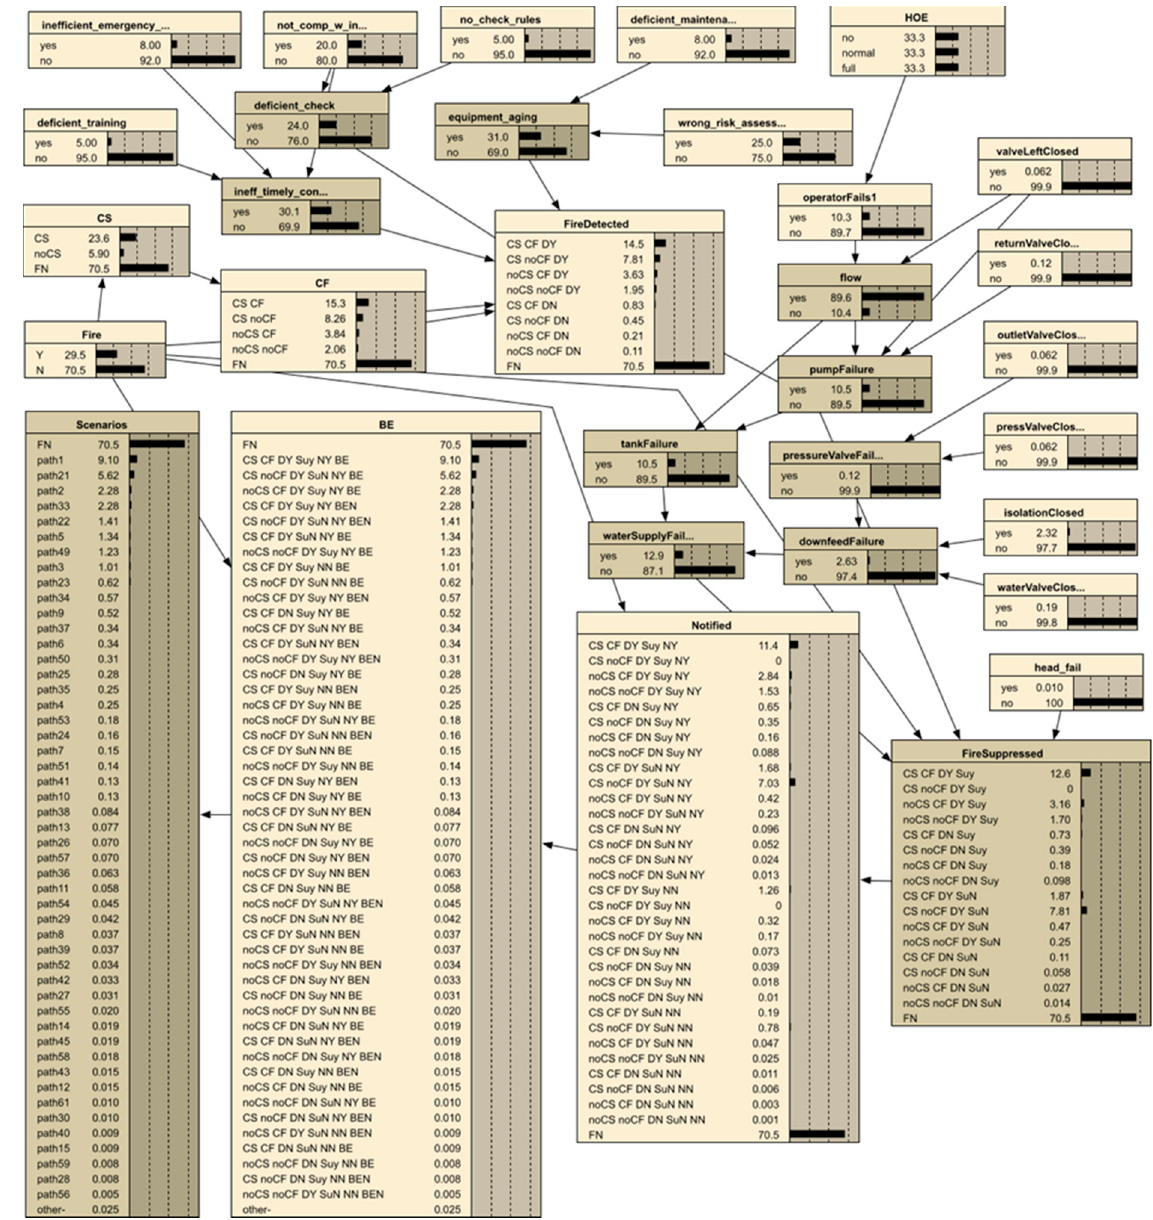
Figure A3. Example of Bayesian Network structure.